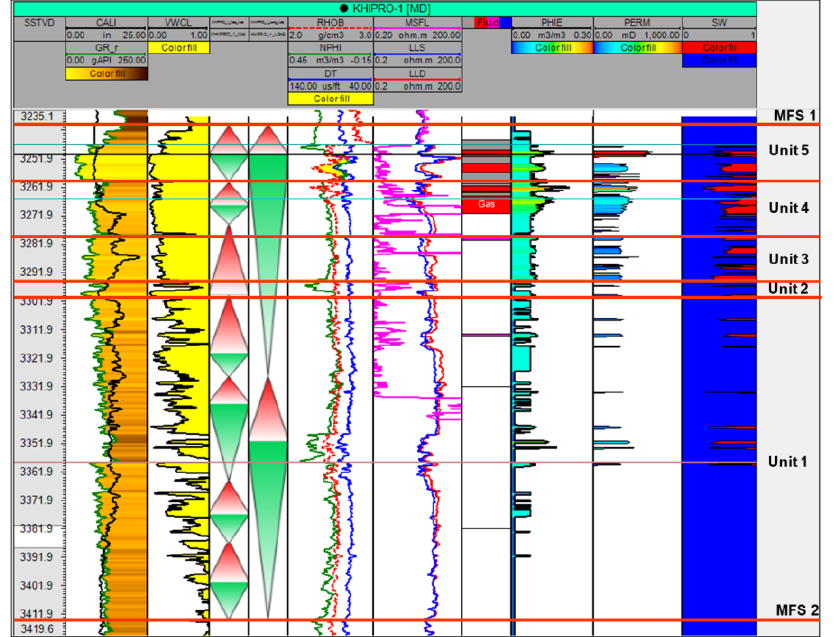
Figure 4. The sequence framework of the hydrocarbon-bearing interval of Miano gas field. Two middle-term sequences and five to seven short-term sequences were identified based on cores and well log data. Five geologic units are divided based on cycles. The conventional gas reservoir develops in the lower part of Unit 5 and the overlain tight gas reservoir develops in Unit 4. Some minor gas layers developed in Units 1–3. Table 1. Lithologies of the geologic units divided in the hydrocarbon interval of Miano gas field and their positions in middle-term sequence.